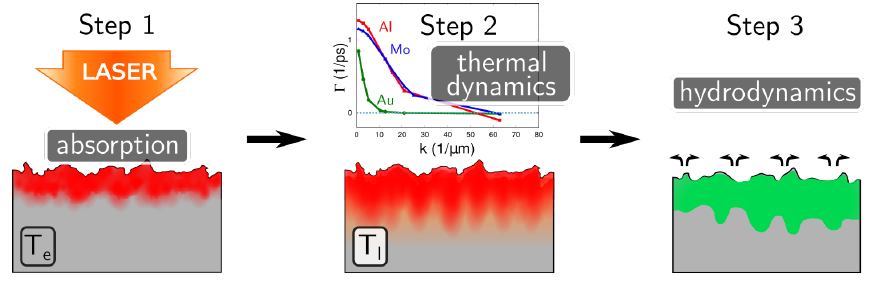
Figure 8. Schematic representation of the